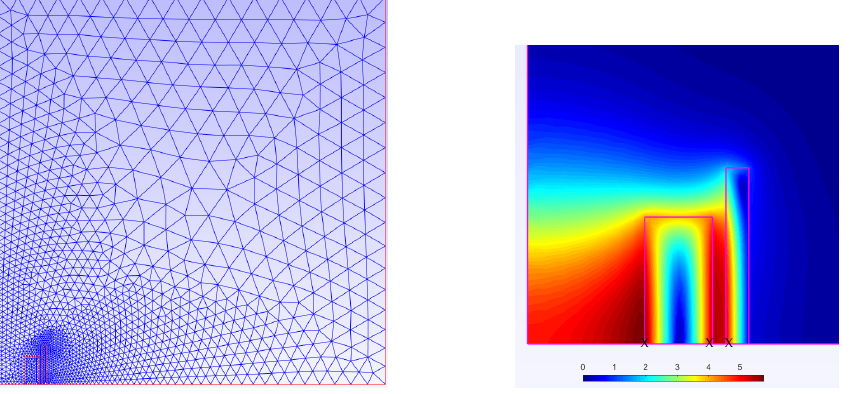
Figure 15. Mesh of the studied domain ( left ); enlarged view of the flux density distribution around the coils ( right ).